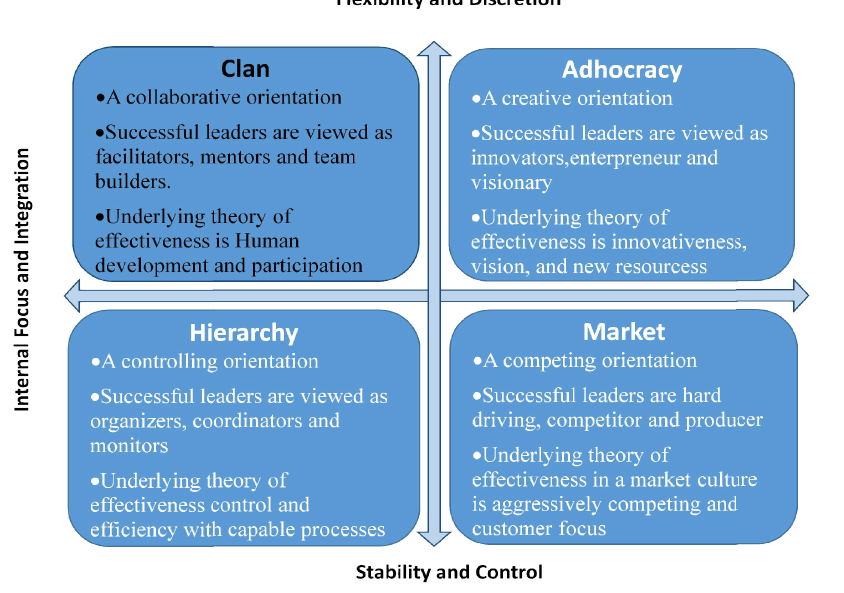
Figure 1. The competing value